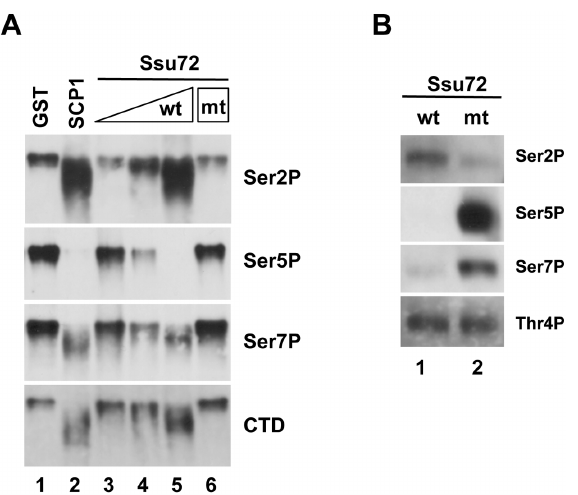
Figure 7. Ssu72 dephosphorylates Ser5P and Ser7P invitro . (A) Fifty ng phosphorylated GST-CTD was incubated with 3.4 m g GST (lane 1), 0.2 m g SCP1 (lane 2), 0.2 m g, 1 m g, or 5 m g wild-type human Ssu72 (lanes 3–5), or 5 m g mutant (C12S) Ssu72 (lane 6), followed by Immunoblotting using the phospho CTD–specific antibodies 3E10 (Ser2P), 3E8 (Ser5P), and 4E12 (Ser7P) and an antibody against the CTD (8WG16). (B) Purified human Pol II was incubated with wild-type (lane 1) or mutant (C12S) Ssu72 (lane 2) and analyzed by Western blotting using phospho CTD–specific antibodies 3E10 (Ser2P), 3E8 (Ser5P), 4E12 (Ser7P), and 6D7 (Thr4P).